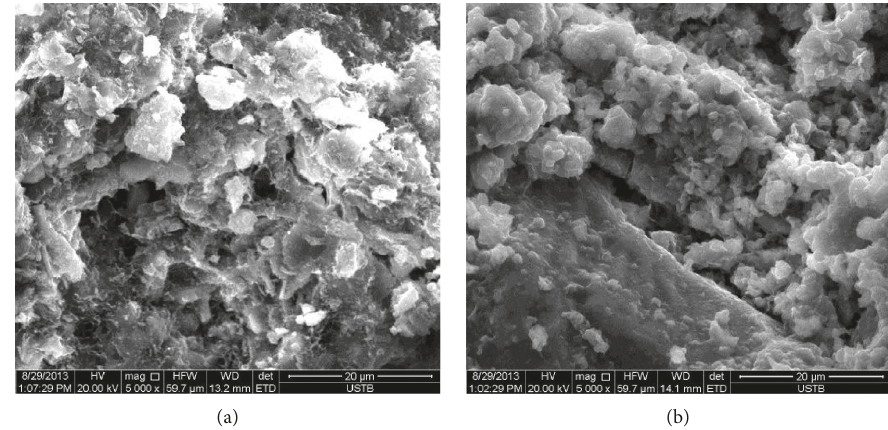
Figure 8: SEM analysis of saline soil solidified by using cement and the cementitious composite material after standard curing 360d. (a) Solidification using cement. (b) Solidification using our improved